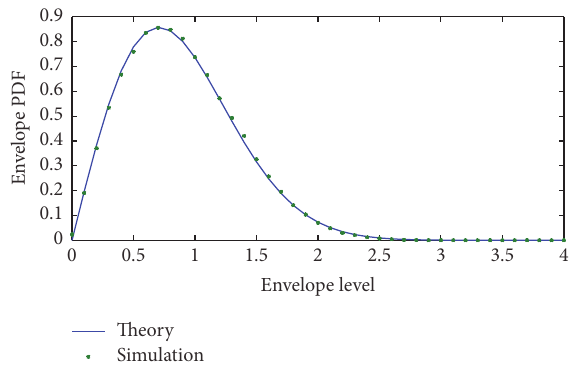
Figure 5: Time-averaged envelope PDF of generated fading chan- nel. The simulation time and channel updating interval are 200 ms and 10ms, respectively. The Rayleigh fading channels during all intervals are assumed to have normalized power. The dotted line denotes the averaged envelope PDF for all time intervals.